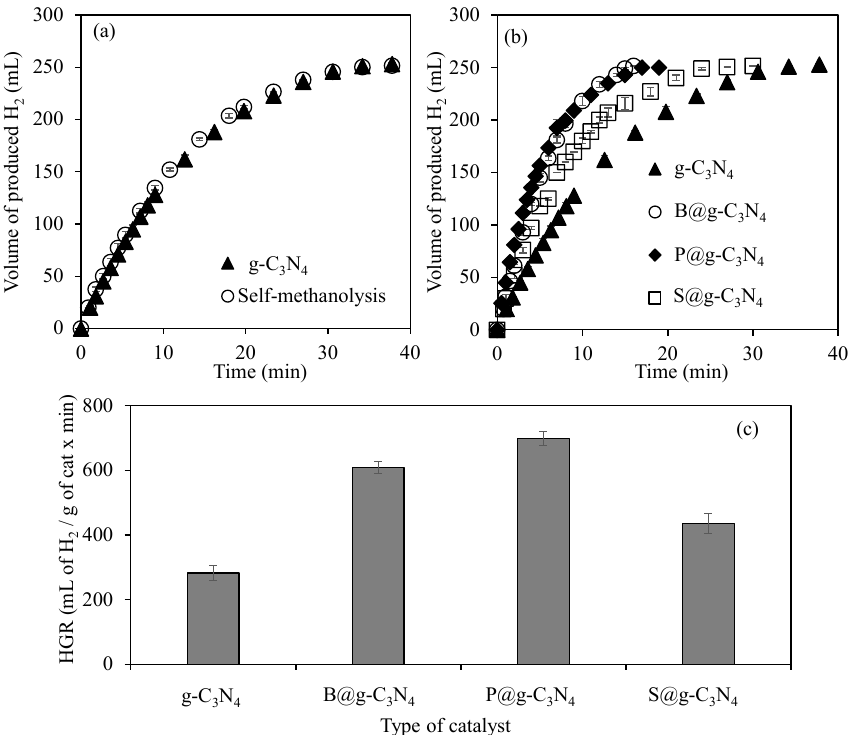
Figure 3. The comparison of catalytic activity of ( a ) native g-C 3 N 4 with self-methanolysis, ( b ) native g-C 3 N 4 with H@g-C 3 N 4 (H: B, P, or S) on the dehydrogenation reaction of NaBH 4 in methanol, and the comparison of calculated HGR values for the g-C 3 N 4 -based-structures-catalyzed dehydrogenation reaction of NaBH 4 in methanol [reaction condition: 50 mg catalyst, 20 mL methanol, 0.0965 g NaBH 4 , 25 °C, 1000 rpm].